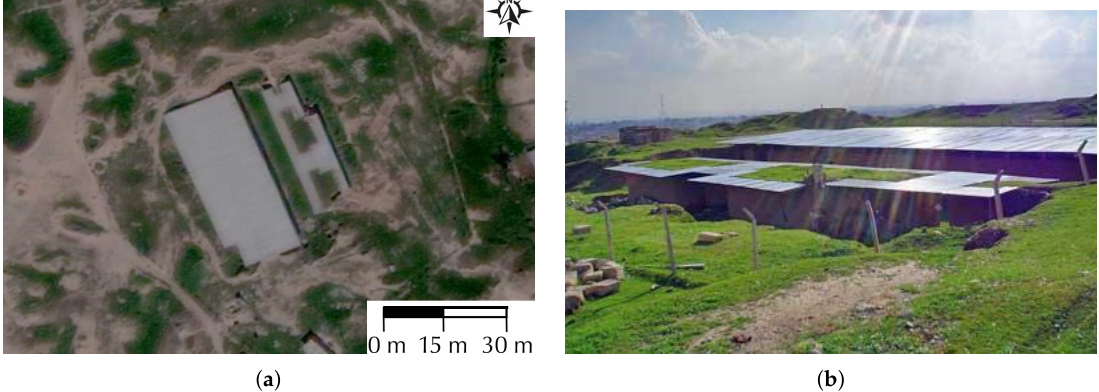
( a ) Figure 19. Overview of the Sennacherib Palace before the destruction: ( a ) GeoEye-1, 1 April 2016 c (cid:13) DigitalGlobe; and ( b ) ground picture of Sennacherib’s Palace 2011